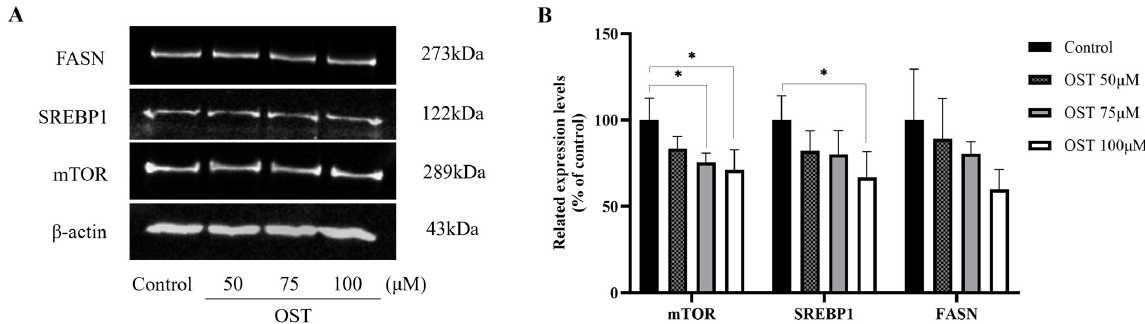
Figure 10. Effect of osthole (OST) on the expression of mTOR, SREBP1, and FASN in 4T1 cells. ( A ) 4T1 cells were treated with OST (0, 50, 75, and 100 μ M) for 48 h. The expression levels of mTOR, SREBP1, and FASN in the cells were detected using western blotting. ( B ) Quantitative analysis using ImageJ software of western blot signal intensity expression relative to β‐ actin loading. Data show the mean ± SD (three independent experiments) compared to that in the control group (0 μ M). * p < 0.05, ** p < 0.01.